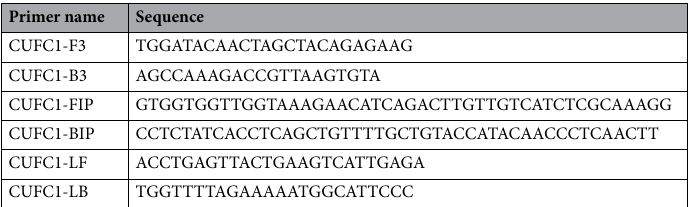
Table 1. Sequence information of LAMP primers for SARS-Cov-2